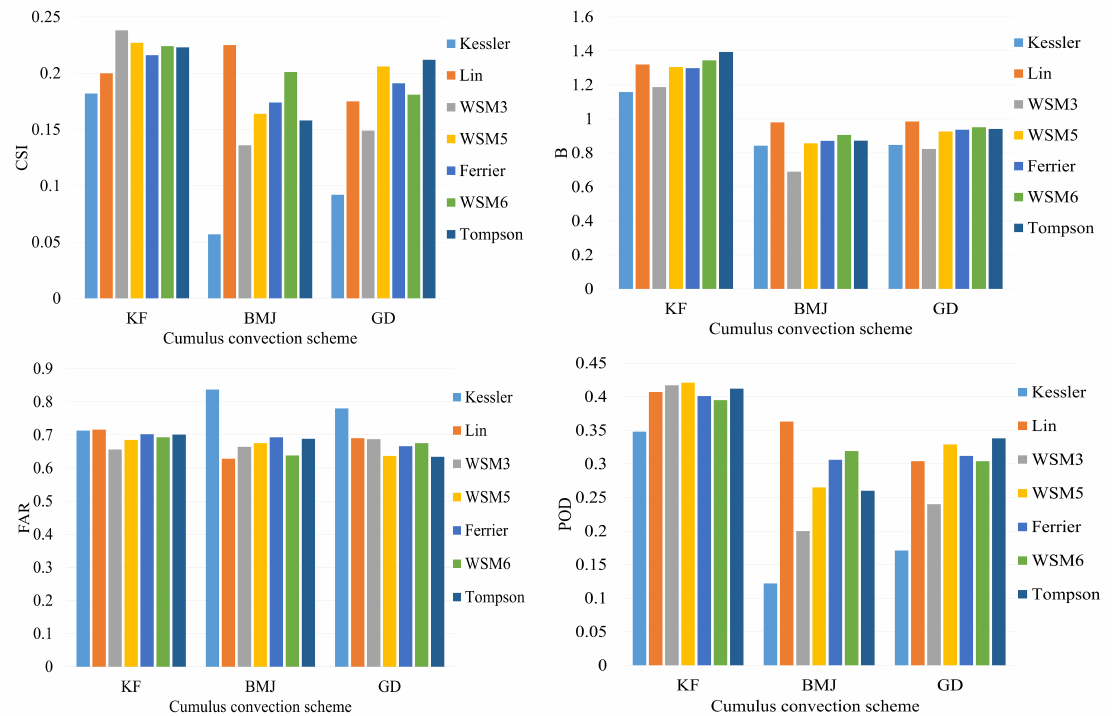
Figure 6. Mean CSI, B, FAR, and POD scores for seven case studies at different physical parameterization schemes (threshold ≥ 100 mm/day). (KF: Kain–Fritsch; BMJ: Betts–Miller–Janjic; GD: Grell–Devenyi; WSM: